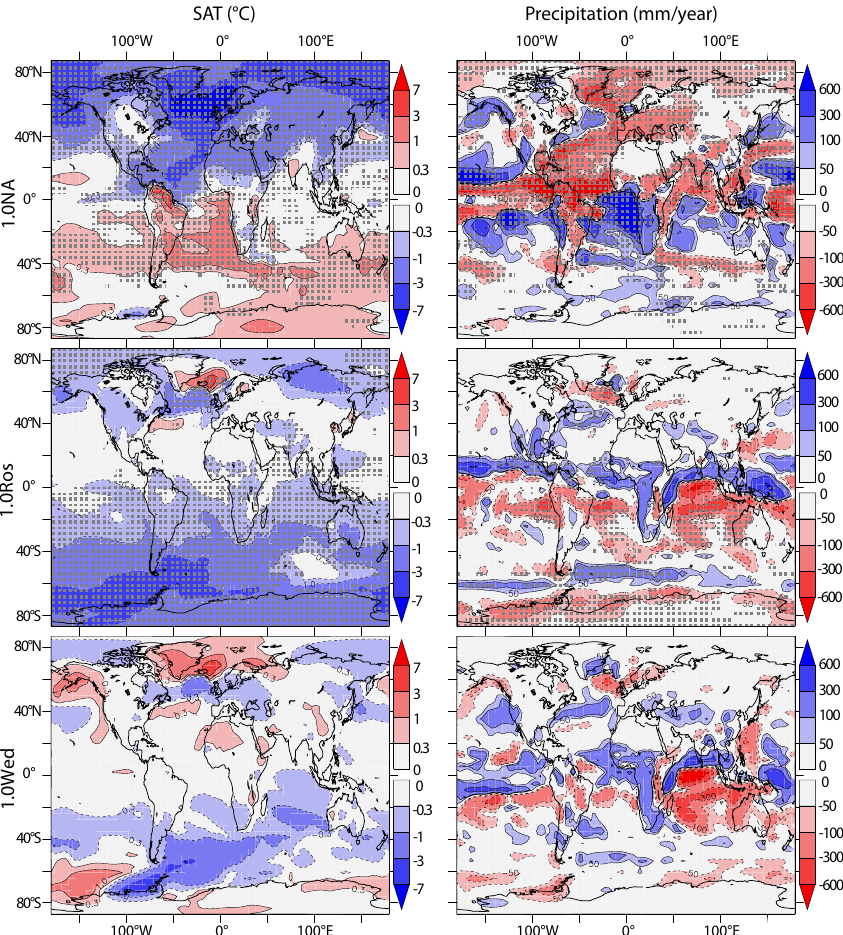
Fig. 2. The left column shows the SAT anomalies ( ◦ C) with respect to the Control by the end of the 100-year perturbation (decadal average of the model years 97–106) for the experiments 1.0NA (top), 1.0Ros (middle), and 1.0Wed (bottom). The right column shows the precipitation anomalies (mmyr − 1 ). Stippled areas indicate where the ensemble mean anomaly is significantly different from zero at the 67% level (Student’s t-Test). Confidence level of the 1.0Wed experiment results is not quantified since there is only one simulation